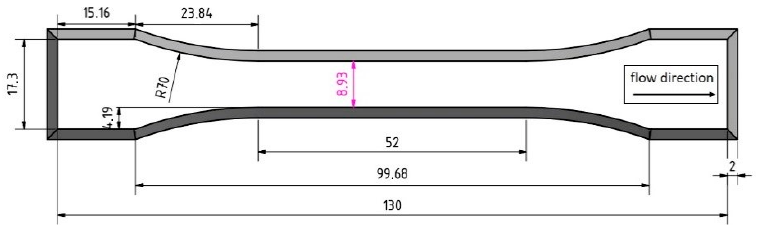
Figure 3. Dimensions of the bone-shaped specimen used for tensile strength tests taken from Pietsch et al.